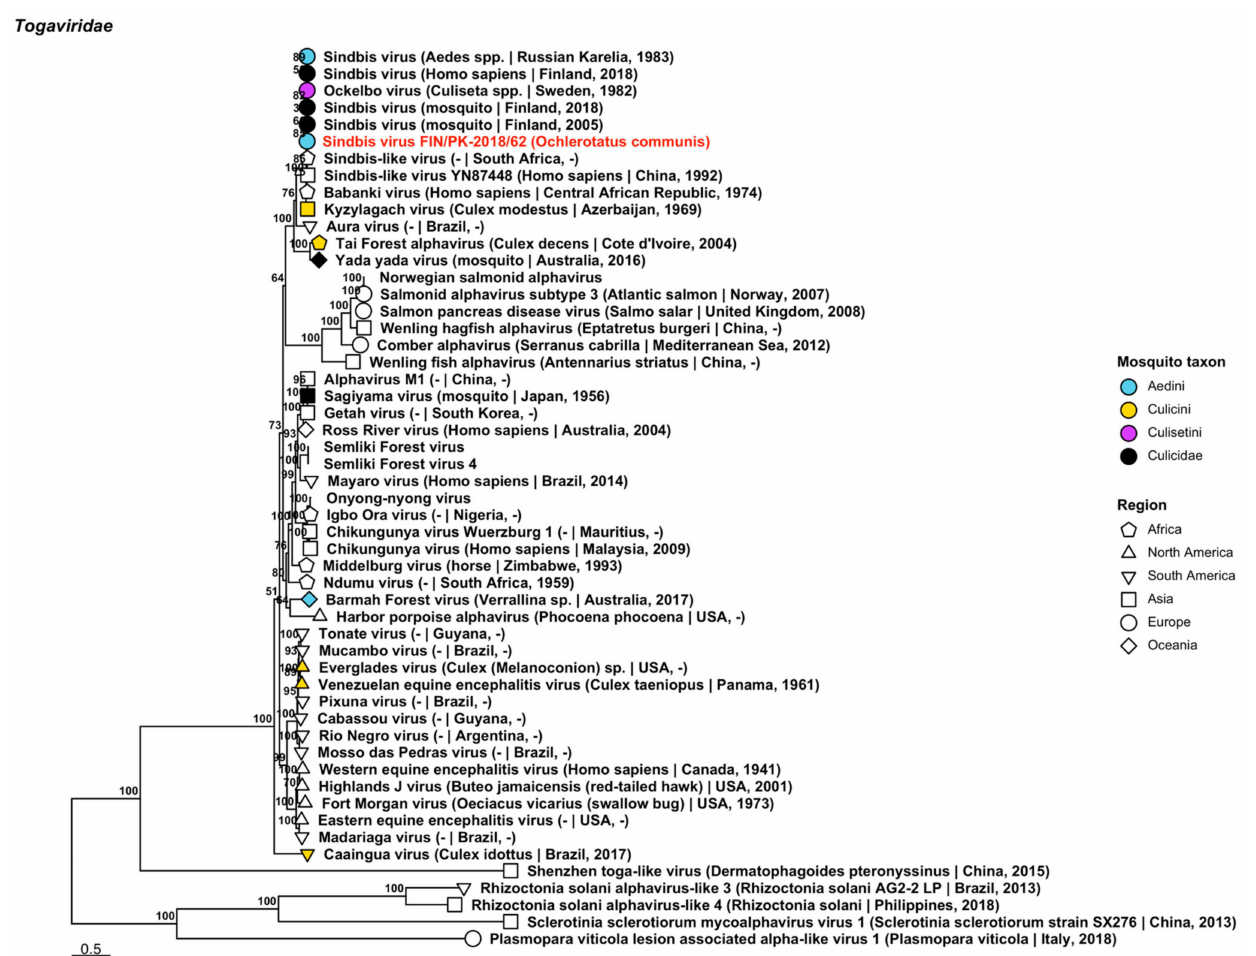
Figure 8. Maximum likelihood tree of Togaviridae . The novel strain of Sindbis virus is displayed in red and was derived from Oc. communis . Sequences from GenBank are black and display the following information after the virus or species name: “(sampled organism(s)|collection country, collection year)”. Tip colours represent the tribe of mosquito from which viruses were obtained. Tip shape represents the continent or region from which the specimens were collected. Trees were constructed from amino acid sequences of virus polymerases >1000 nt, aligned with MAFFT and computed with IQ-TREE2 using ModelFinder and 1000